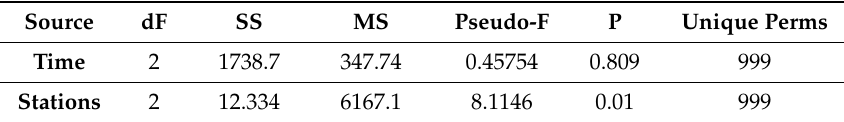
Table 4. PERMANOVA analysis regarding blue crab abundances.